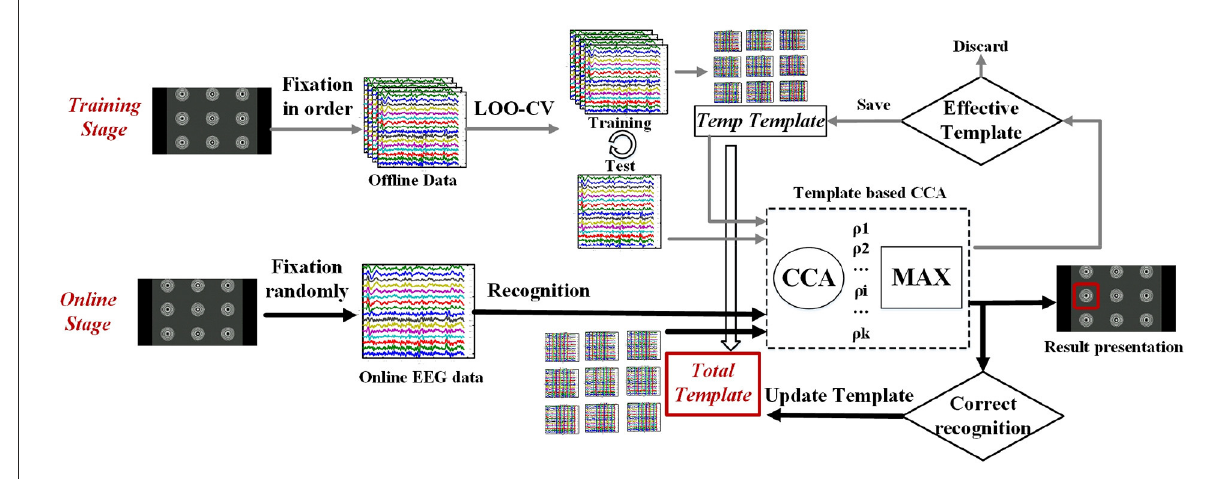
FIGURE3 The flow chart of the recognition algorithm is based on CCA and a complex template.